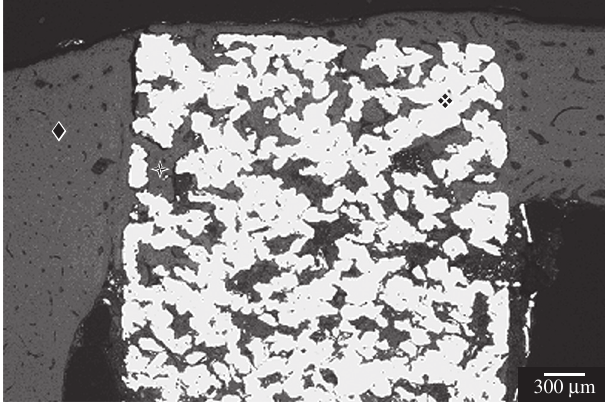
Figure 5. SEM photomicrograph of porous titanium scaffold (  ) 4 weeks after implantation in rabbit tibia (  ), and bone ingrowth (  ).